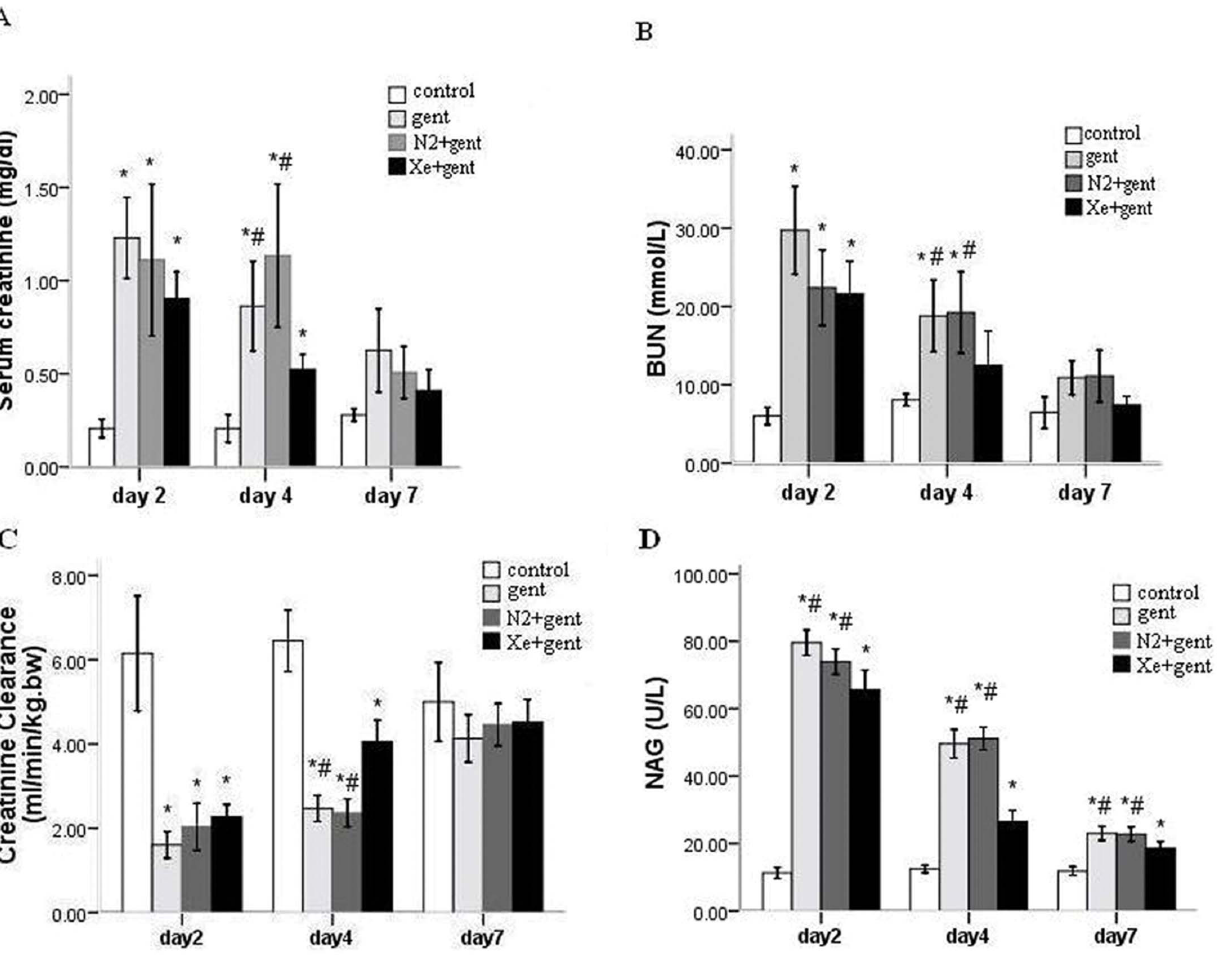
Figure 1. Xenon protected renal function against gentamicin-induced nephrotoxicity. A: serum creatinine concentration (Scr) from all groups 2, 4 and 7 days after 7-day gentamicin or saline injection. B: blood urea nitrogen concentration (BUN). C: creatinine clearance (Ccr). D: Urinary N-acetyl- b -D-glucosaminidase (NAG). Xenon treatment significantly attenuated the elevation of Scr, BUN, NAG and reduction of Ccr 4 days after 7-day gentamicin injection compared with the gentamicin group and N 2 + gentamicin group. *P , 0.01 vs. control group; # P , 0.05 vs. Xe + gentamicin group. n=6/group at each time point.